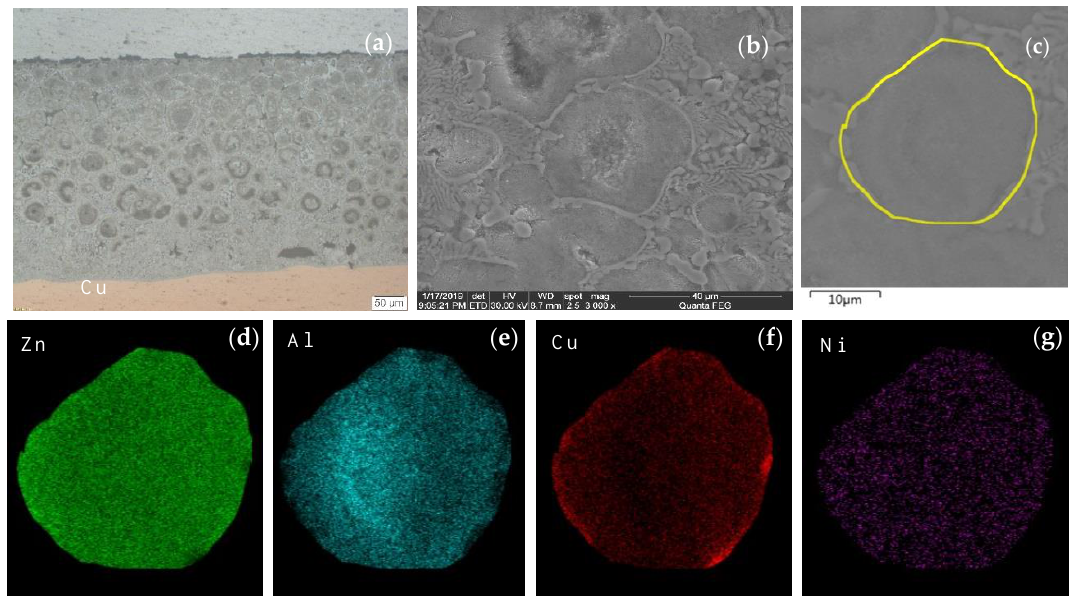
Figure 5. Spherulite OM morphology, SEM morphology, EDS layered image and composition distribution of ultrasonic-assisted semi-solid sample: ( a ) OM morphology of spherulite in the brazed joint zone; ( b ) SEM morphology of dendrite structure in the brazed joint zone; ( c ) EDS hierarchical images in spherulite; ( d ) Zn distribution in spherulite; ( e ) Al distribution in spherulite; ( f ) Cu distribution in spherulite; ( g ) Ni distribution in spherulite.